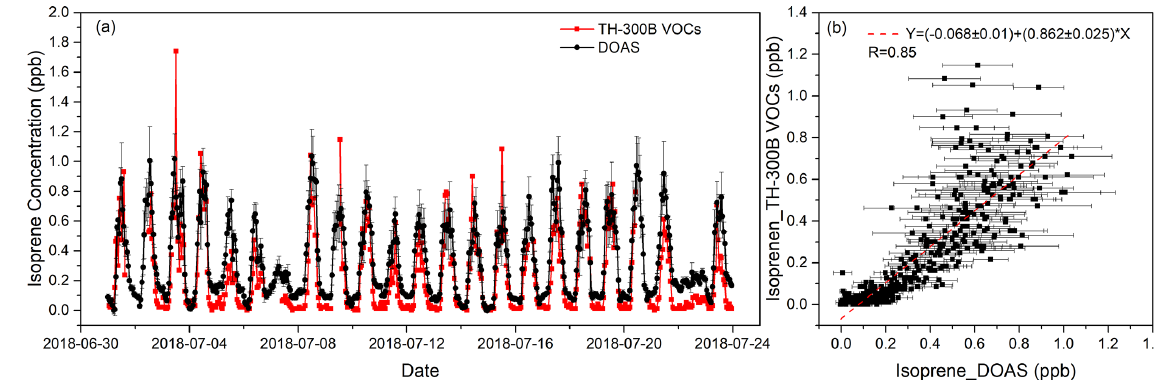
Figure 6. The comparison of hourly isoprene measured by DOAS and online VOCs during the field